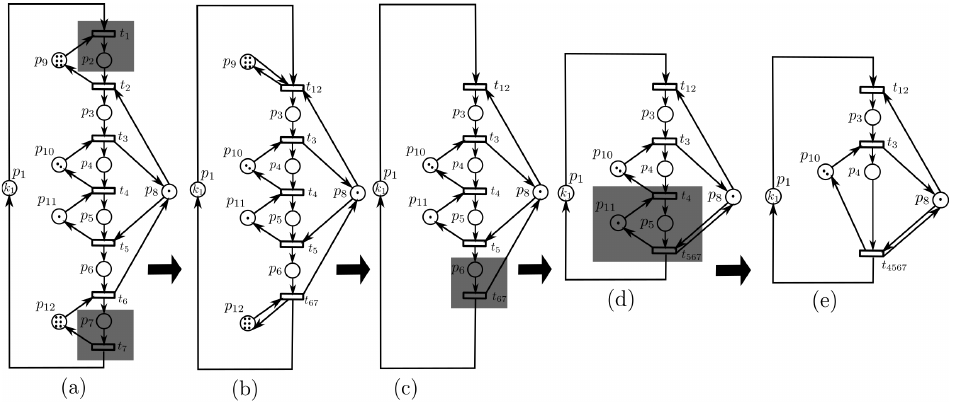
Figure 13. Reduction process of a net model. ( a ) Original net model, post-fusion of transitions t 6 and t 7 , and pre-fusion of t 1 and t 2 are shaded. ( b ) First reduced net with self-loop places that can be removed. ( c ) Second reduced net, post-fusion of transitions t 5 and t 67 is shaded. ( d ) Third reduced net, macrotransition is shaded. ( e ) Final reduced